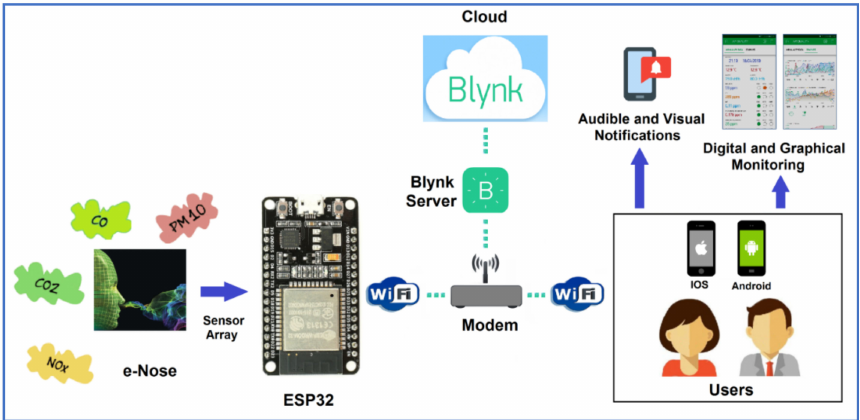
Figure 1. The proposed e-nose system